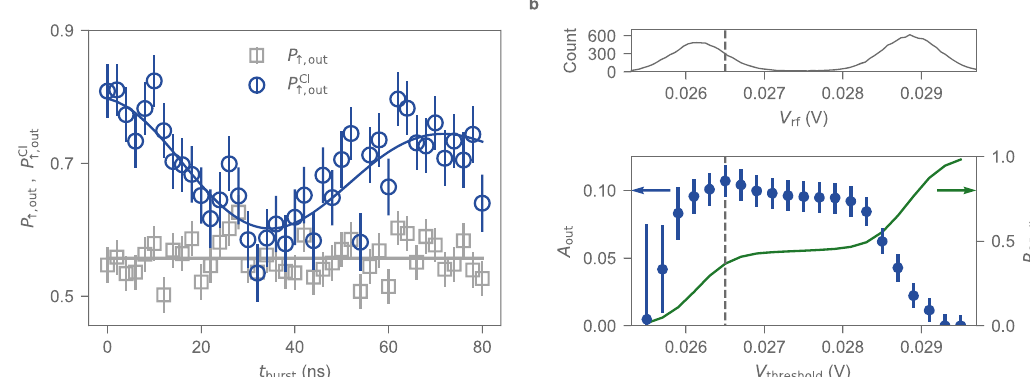
Fig. 3 Demonstration of the QT protocol. a Spin-up probability of Q3 obtained as a function of the MW burst time t burst (0, 2, 4, … , 80 ns) used to vary the spin orientation of Q1. Error bars represent the SE. Gray squares are P " ; out taken regardless of the outcome of the Bell extracted from the data conditioned on the singlet outcomes measurement. The gray solid line is a fi t to a constant value. Blue circles are P CI " ; out of the Bell measurement. The blue solid line is a fi t to A out cos 2 π f in t þ ϕ in ð determined from the fi t in P CI " ; . The threshold voltage used in a is shown by a black dashed line. The upper panel shows the histogram of the out Bell measurement signal V rf . The lower panel shows A out and the singlet probability, P S ; Bell , as a function of V threshold . V rf lower (higher) than V V A threshold is judged as singlet (triplet). As threshold is increased, out decreases because the accuracy of the classical information decreases. On the left side of the black dashed line, A out decreases as the number of singlet outcomes in the Bell measurement decreases and P CI " ; cannot out be fi tted well.